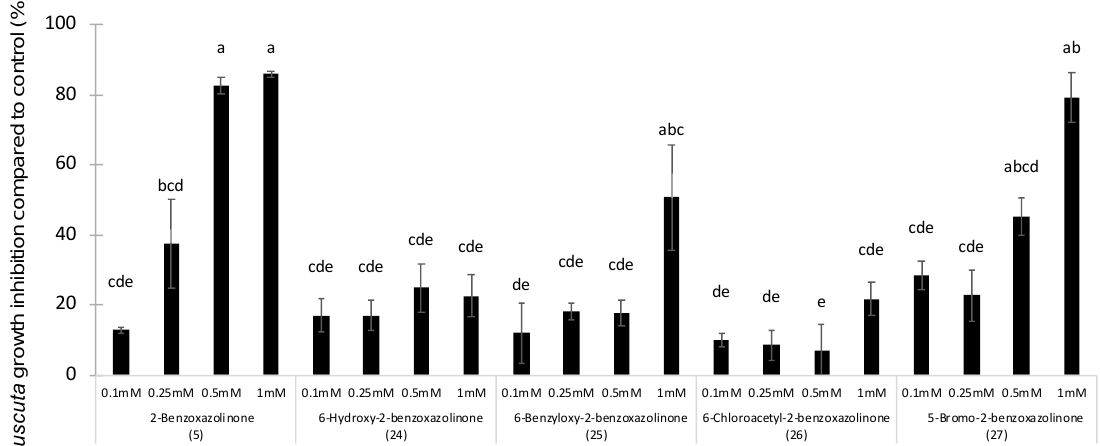
Figure 4. In vitro assessment of the Cuscuta growth inhibition induced by 2-benzoxazolinone ( 6 ) and its derivatives ( 24 – 27 ). Bars with different letters are significantly different (Tukey test at p < 0.05). Error bars represent the standard error of the mean.